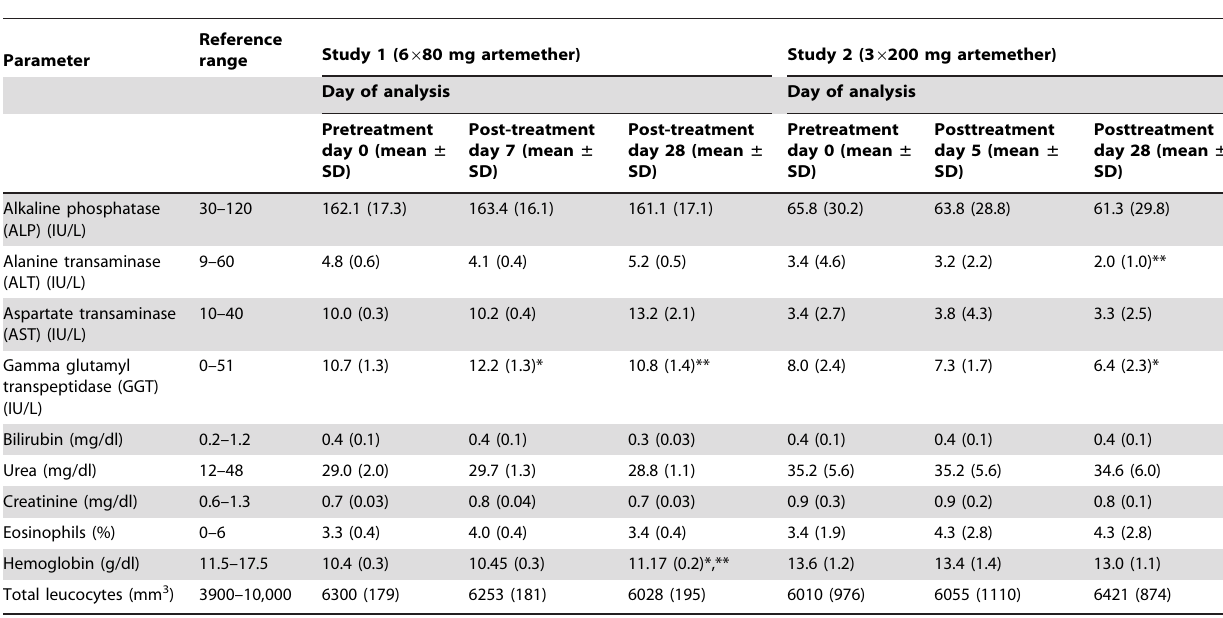
Table 3. Liver and renal function and hematological parameters pre- and posttreatment with artemether.